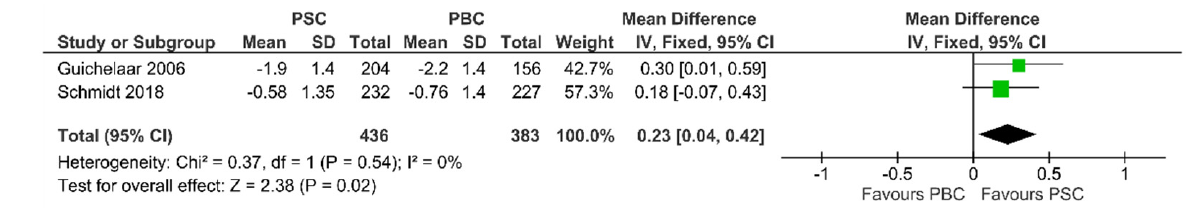
Figure 4. Forest plot assuming a fixed-effects model for T-score PSC vs. PBC [30,33].